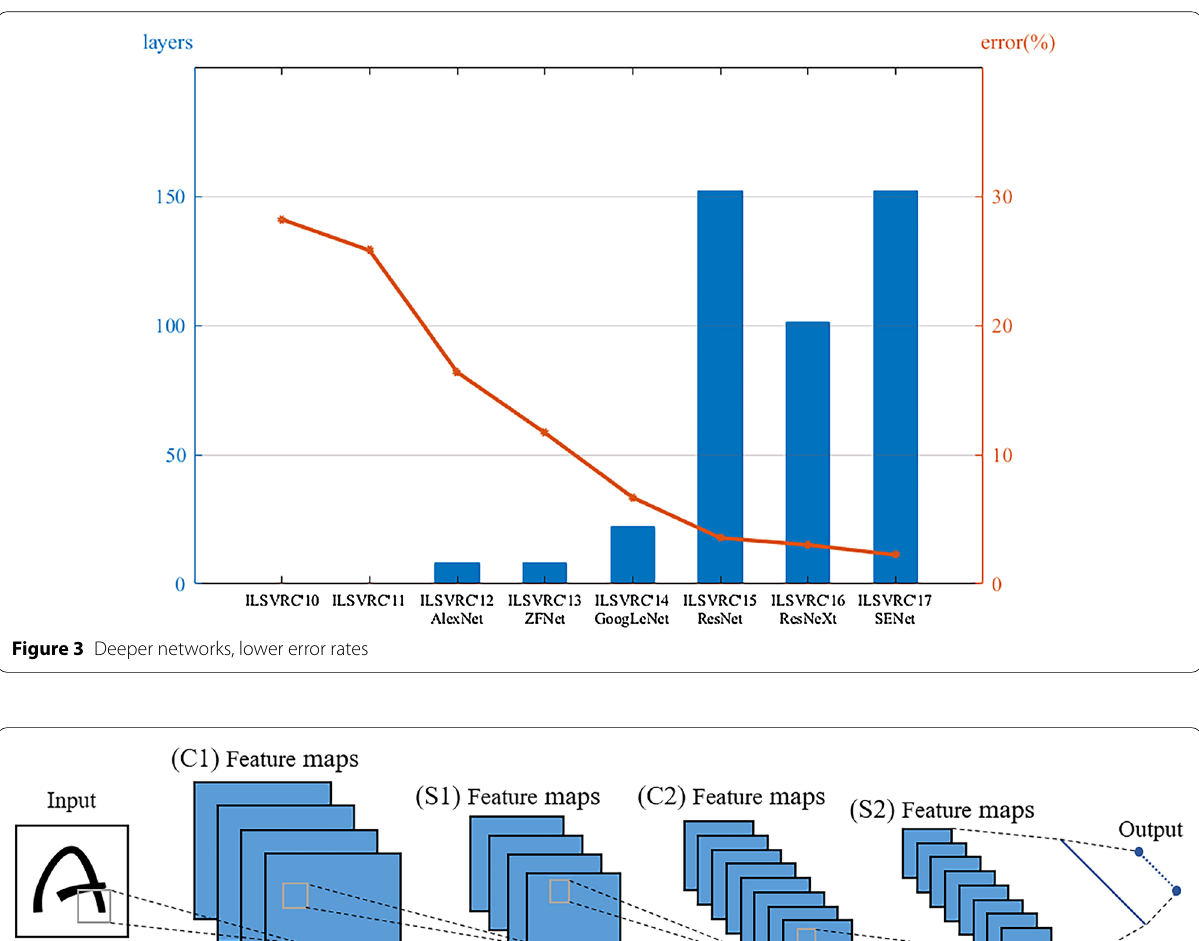
Figure 4 CNN architecture and